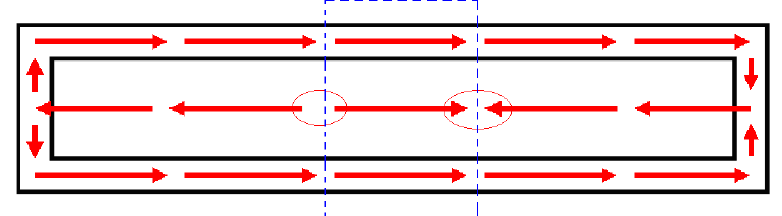
Figure 10. Magnetic field distribution of the whole sensor while h